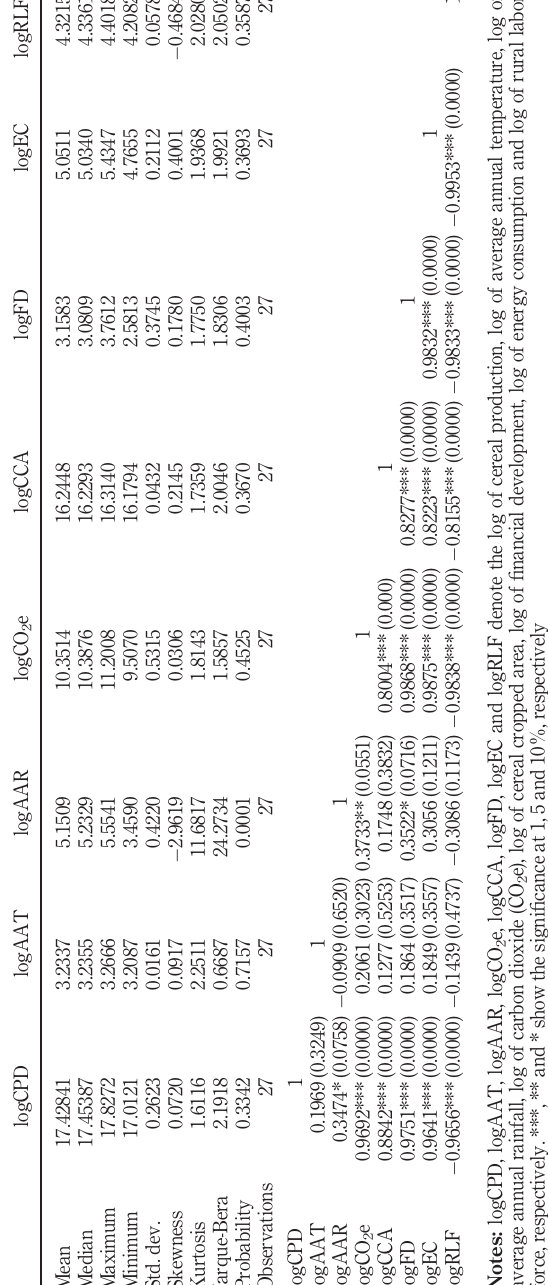
Table A2. Descriptive statistics and correlation